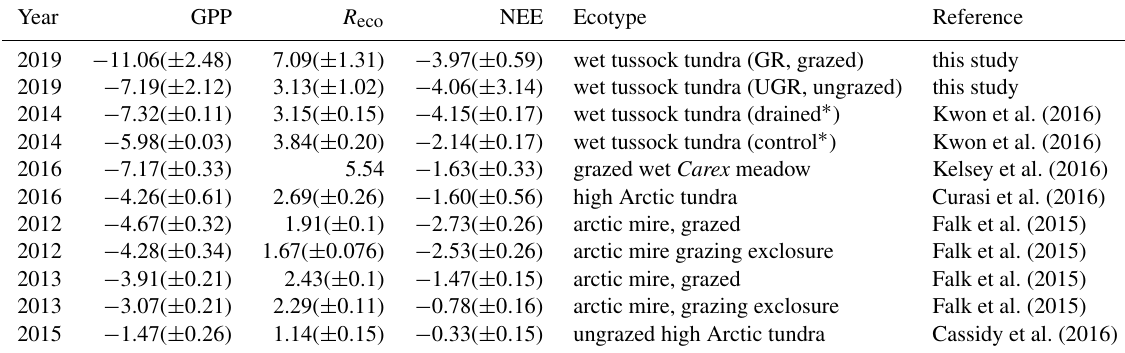
∗ Indicates sites in the same area as UGR in this